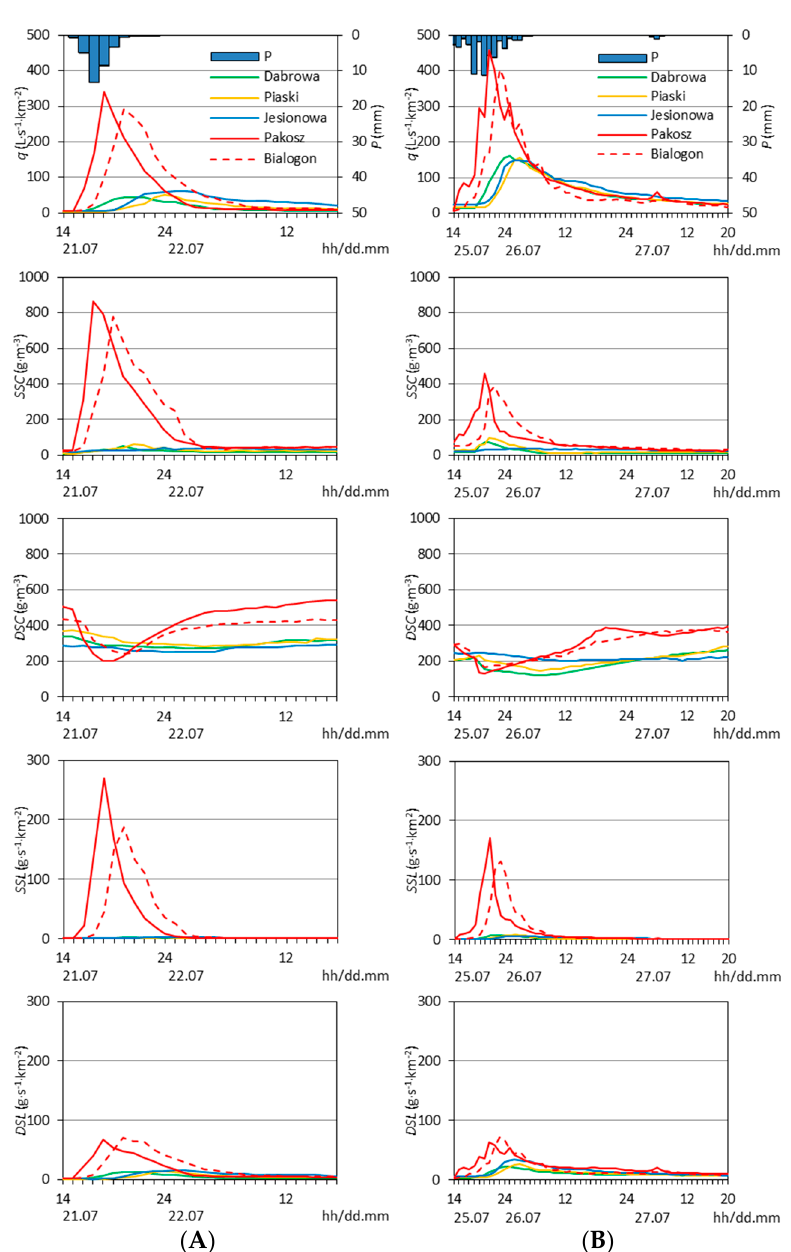
Figure 4. Precipitation ( P ), specific runoff ( q ), suspended solids concentration ( SSC ) and dissolved solids concentration ( DSC ), suspended solids specific load ( SSL ) and dissolved solids specific load ( DSL ), during rainfall-induced floods in the Silnica catchment on ( A ) 21 July 2001 and ( B ) 25 July